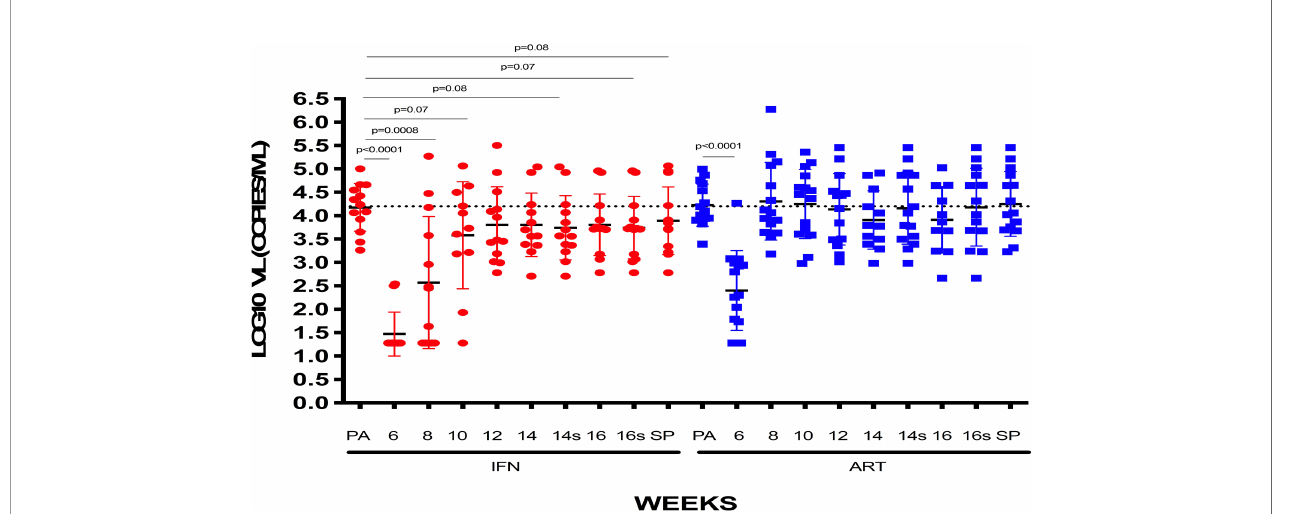
FIGURE 5 | VL [log 10 mean (SE) copies/ml] of patients receiving or not IFN: VLs at pre-ART, weeks 6, 8, 10, 12, 14, and 16 of follow-up and set-point are represented for patients who received IFN or not, independently of being previously